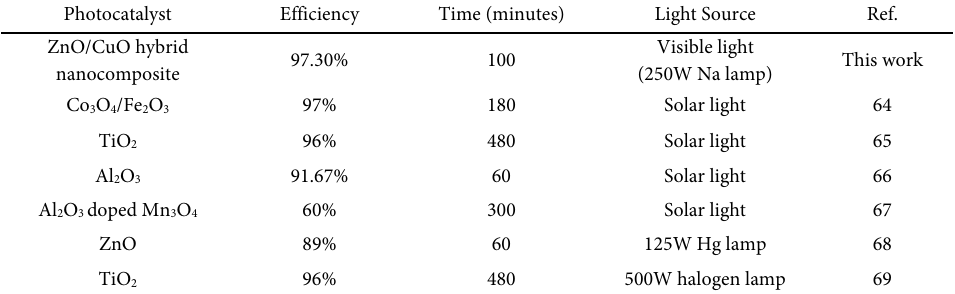
Table 5. Comparison among the photocatalytic efficiency of various photocatalysts for photodegradation of BCB